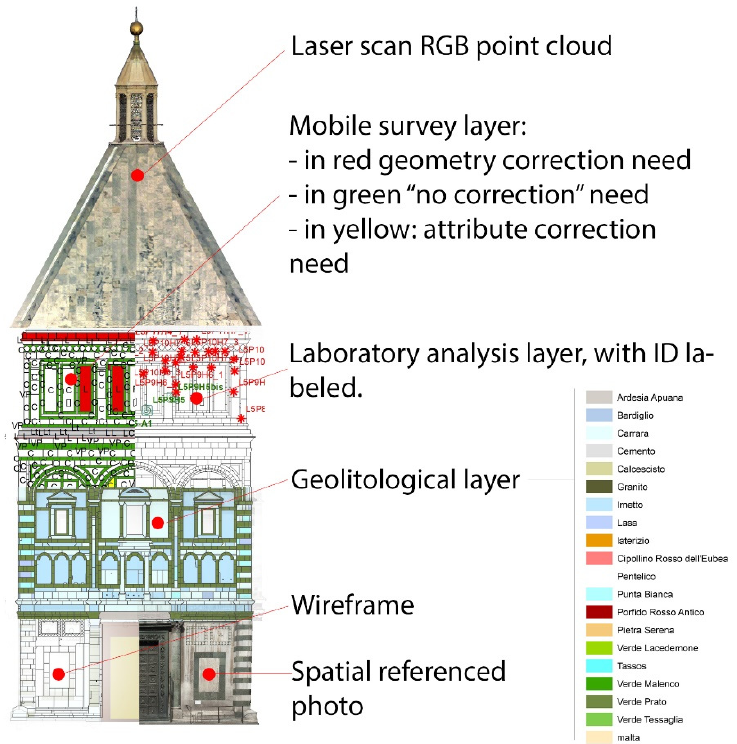
Figure 1. Example of the integration make possible with GIS/SIS software.